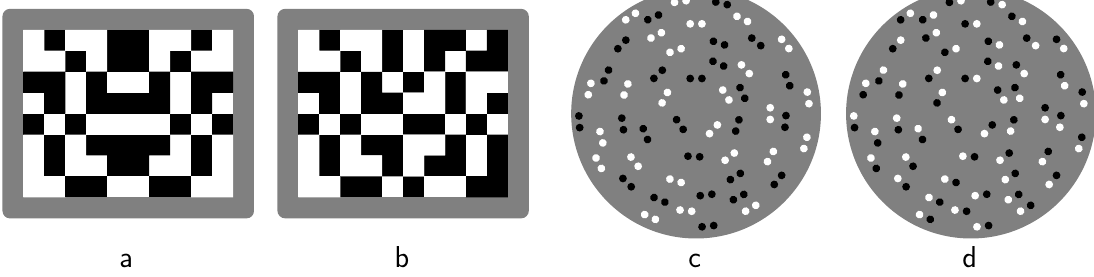
Figure 2. Contrast polarity and regularity detection. The symmetry in the checkerboard pattern in panel ( a ) is perceptually destroyed by the contrast polarity reversal in its right-hand half in panel ( b ); The Glass pattern in panel ( c ), with dipoles consisting of either two black or two white dots, exhibits a clear moiré effect, which disappears in panel ( d ), where all dipoles are identical with one black dot and one white